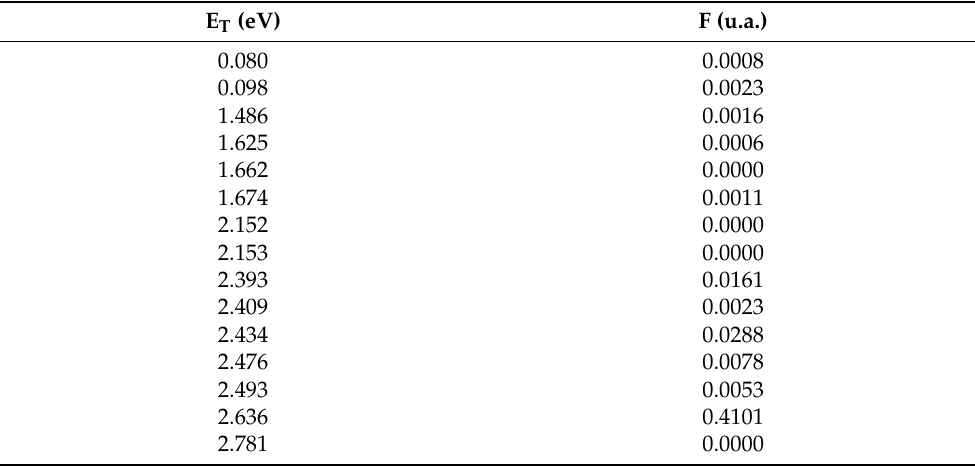
Table 3. The first 15 singlet–singlet transitions allowed. E T is the energy of the electronic transition, and f the oscillator